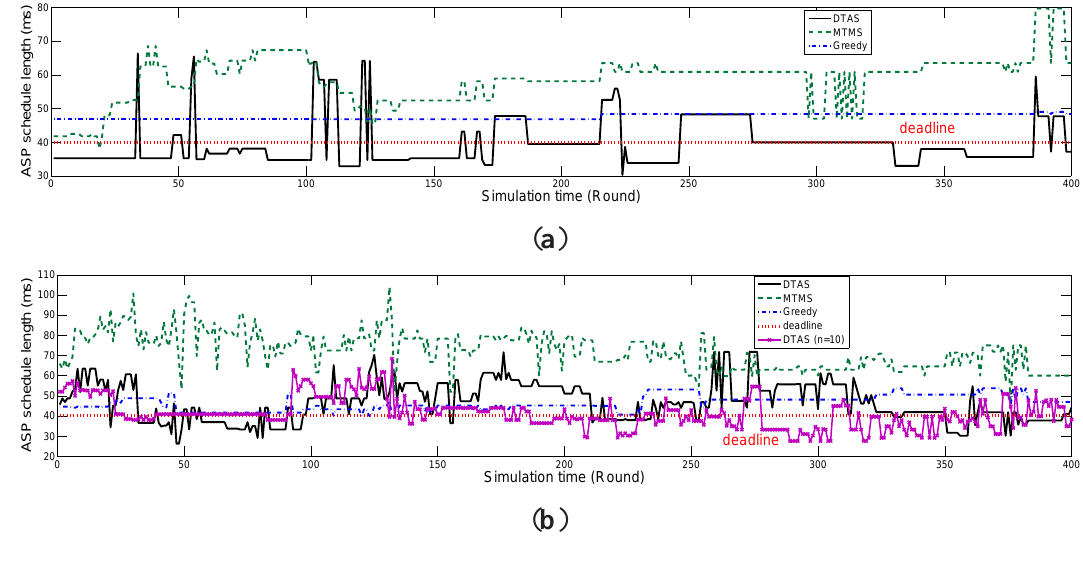
Figure 17. Comparison of algorithm SL for different node mobilities in real-time. ( a ) low mobility, p = 0 . 3 , ν = 1 m/s ; ( b ) high mobility, p move move